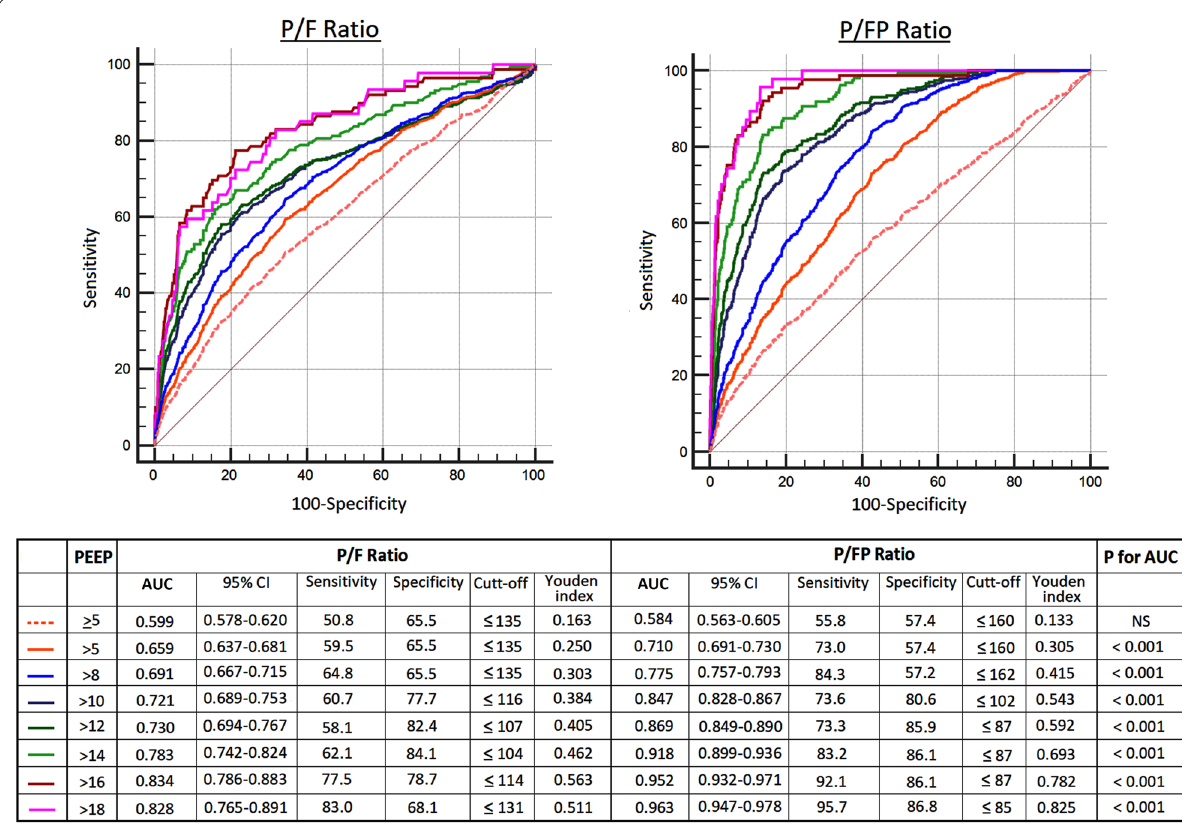
ratio of the partial pressure of arterial oxygen (PaO 2 ) to the fraction of =